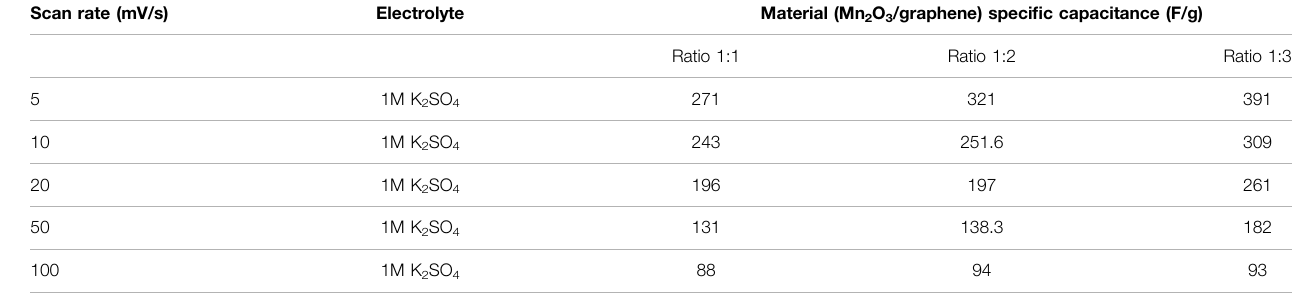
TABLE 3 | Comparison of cyclic voltammetry (CV) results of Mn 2 O 3 /graphene composites. Scan rate (mV/s)